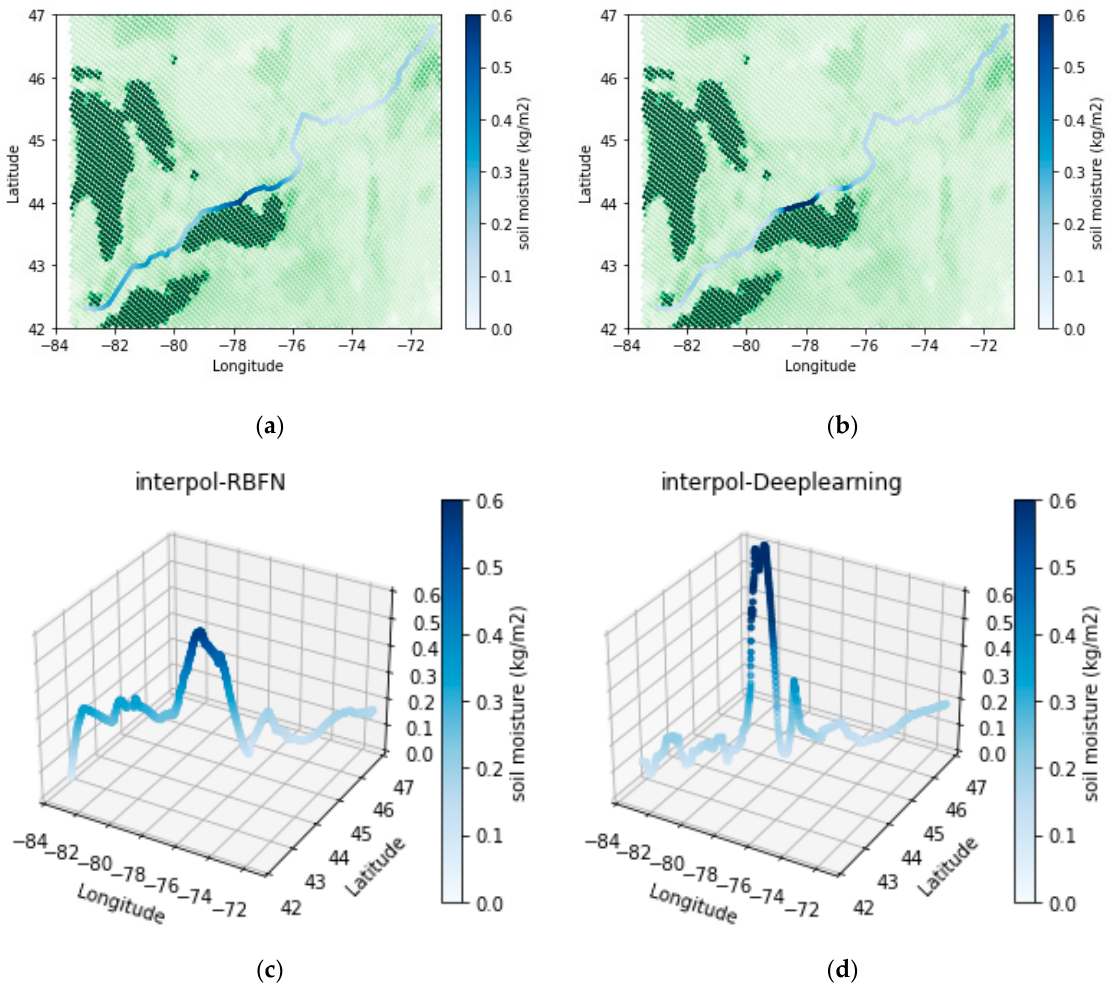
Figure 9. Interpolation soil water content results along the railroad by ( a ) RBFN ( b ) Deep learning ( c ) 3D graph of RBFN ( d ) 3D graph of Deep learning.